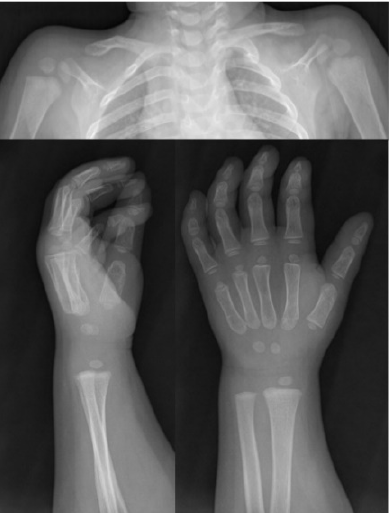
Figure 2. Radiologic images from patient 2. Note the mild hypoplasia of the right clavicle compared to contralateral, the delayed ossification in the carpus and dysmorphism at the level of the intermediate phalanx of the fifth finger and at the base of the second metacarpus.